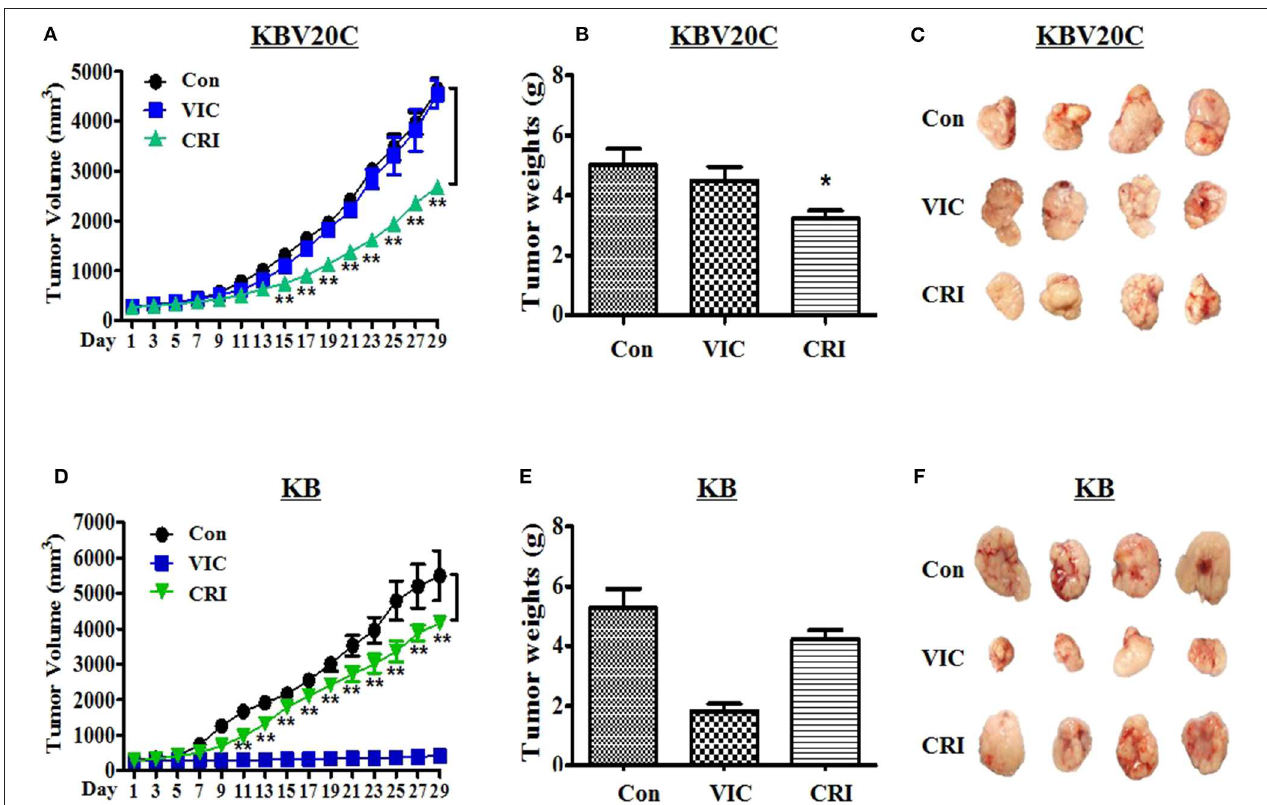
FIGURE 4 | Crizotinib specifically reduces the growth of resistant KBV20C cell tumors in a xenograft model. The experiments were performed as described in Materials and Methods. Mice with established and palpable tumors with KBV20C (A–C) or KB (D–F) cells were randomized into three groups. Each group with four tumor-bearing mice were administered with vehicle control (Con), vincristine (VIC; 0.5 mg/kg/i.p.), or crizotinib (CRI; 25 mg/kg/p.o). There was no statistically significant difference in body weight of the mice among the treatment groups. (A,D) The changes in tumor volume with time after tumor cell implantation. Tumor volume was measured every other day. During the 28-day treatment, tumor volumes were estimated using measurements taken from external calipers (mm cubed). The graph represents tumor size of control, vincristine (VIC)- or crizotinib (CRI)-treated mice. We performed Student’s t -test to compare control and crizotinib-treated groups. (B,E) The weight of tumor was measured at the end of treatment. Mice from each group were sacrificed at 28 days and tumors were isolated from mice at the end of treatment. The weight of tumor was measured at the end of treatment. The weight of each harvested tumor was measured and plotted. We performed Student’s t -test to compare control and crizotinib-treated groups. Each bar represents the mean of tumor weight. Each data point represents the mean ± SD from four mice. * P < 0.05, ** P < 0.01. (C,F) Tumors were isolated from the mice at the end of treatment. The photograph of tumor size was taken on the 28th day after implantation. Photographs of representative tumors are